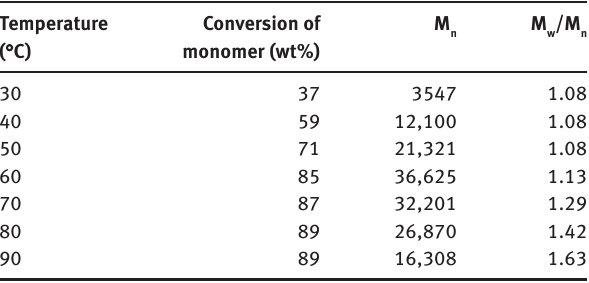
a Maghnite-H + /tetraphenyltetramethylcyclotetrasiloxane (D 4Ph,Me ) weight ratio = 2%. Reaction time: 150